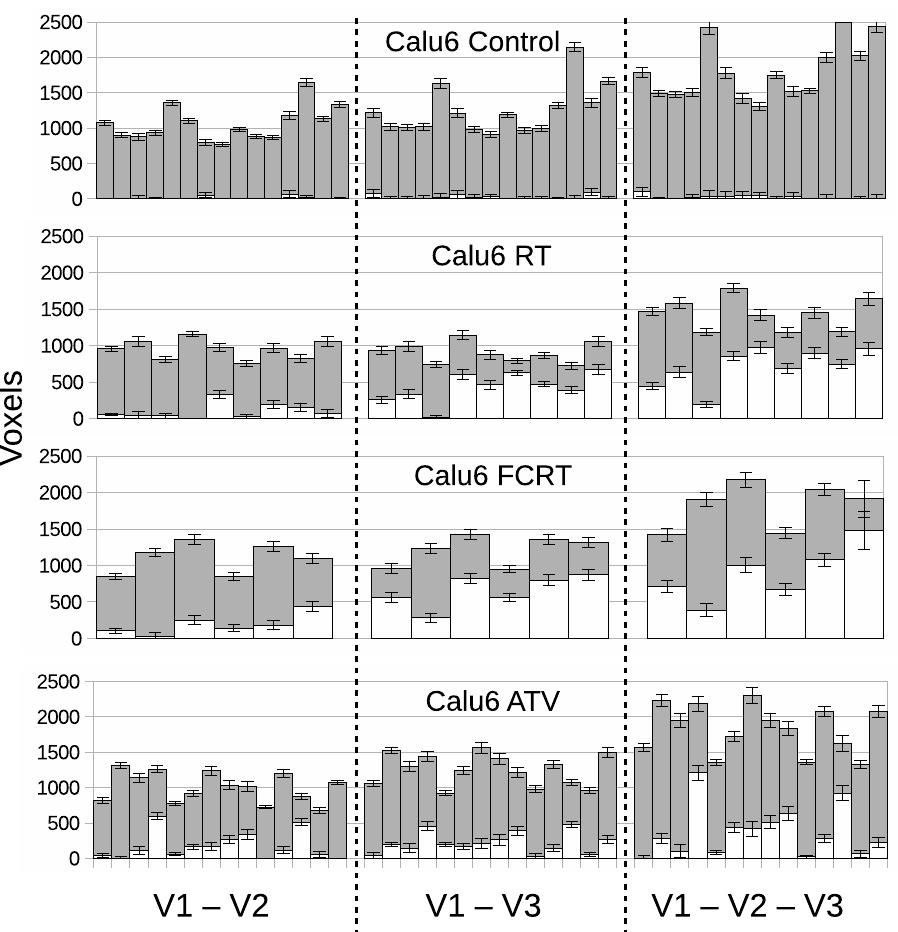
Figure 6. Per-tumor LPM assessment of treatment effects showing lower bound on affected tissue ( Q T ± σ ) in white and unaffected ( Q C ± σ ) in grey. Each bar represents a different tumor. The top plot confirms the null hypothesis of no treatment effects within the control cohort, followed by treatment cohorts showing responses. From left to right, cohorts are assessed using different pairs and triplet of visits corresponding to the V1–V2, V1–V3 and V1–V2–V3